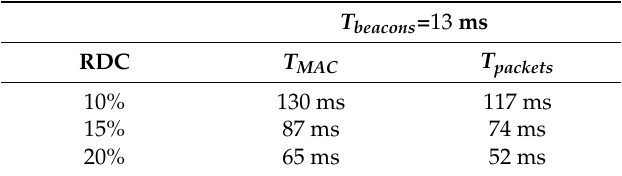
Table 1. MAC times for different RDC values.